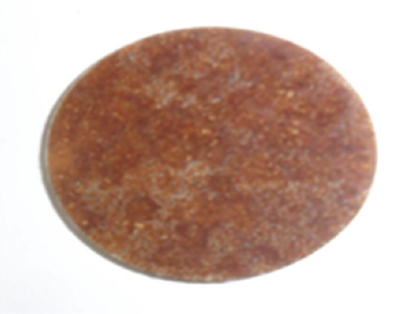
Figure 2: BBF/PP composites in pressed form.